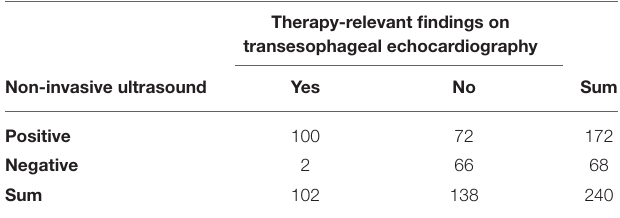
TABLE 2 | Cross tabulation of non-invasive ultrasound vs. transesophageal echocardiography (TEE). Therapy-relevant findings on transesophageal